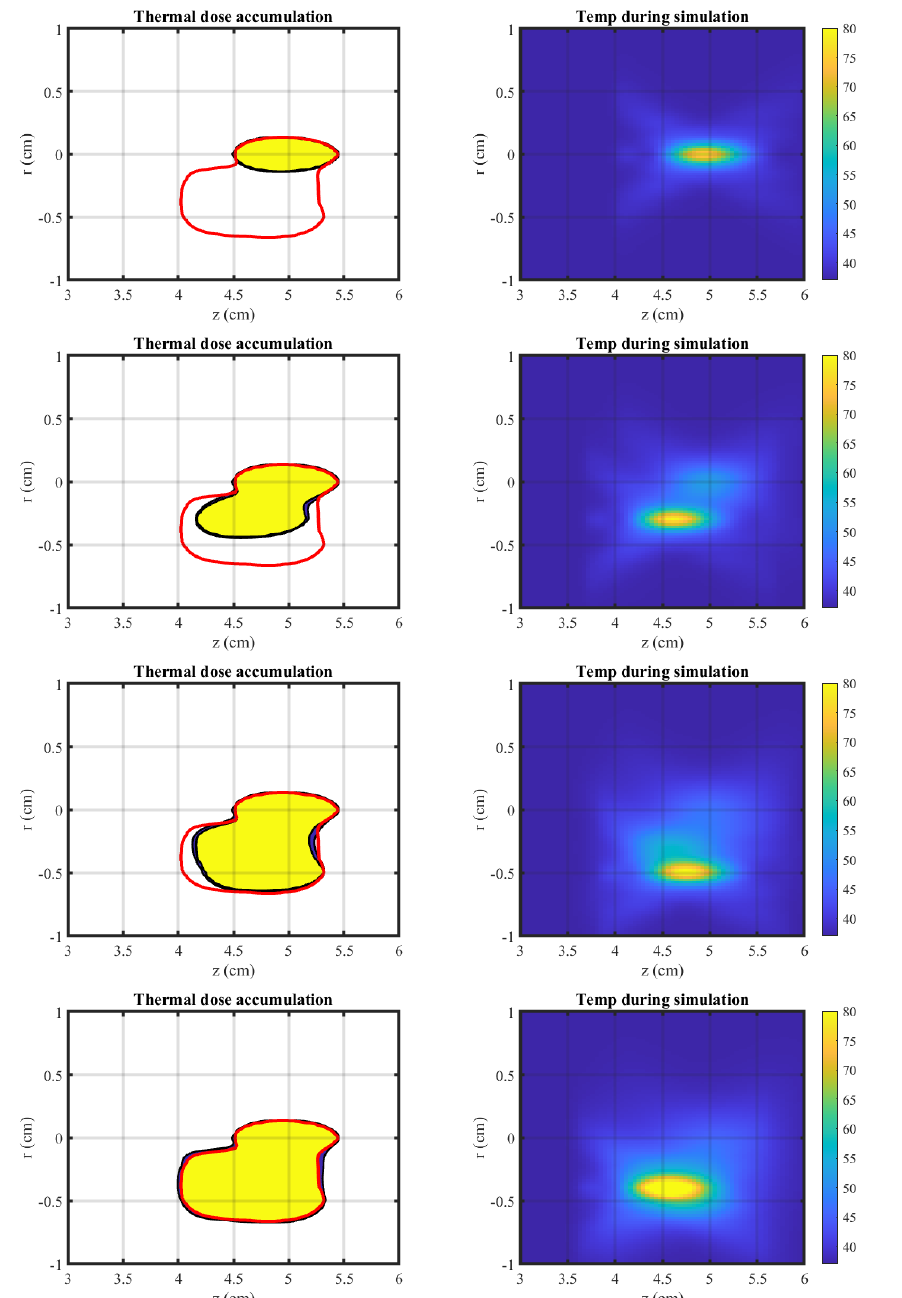
Figure 14. Visualization of a perfect treatment plan composed of 4